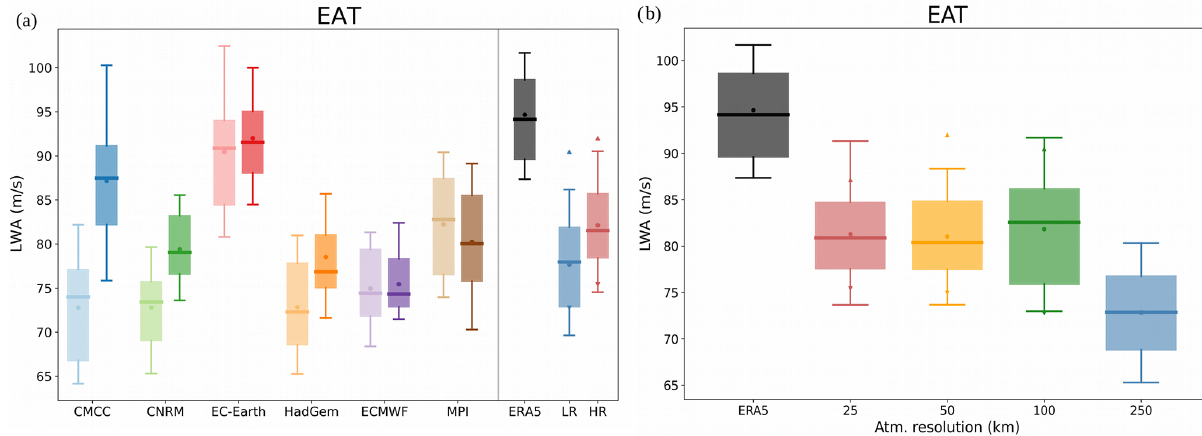
Figure 13. As in Fig. 4 but for the EAT